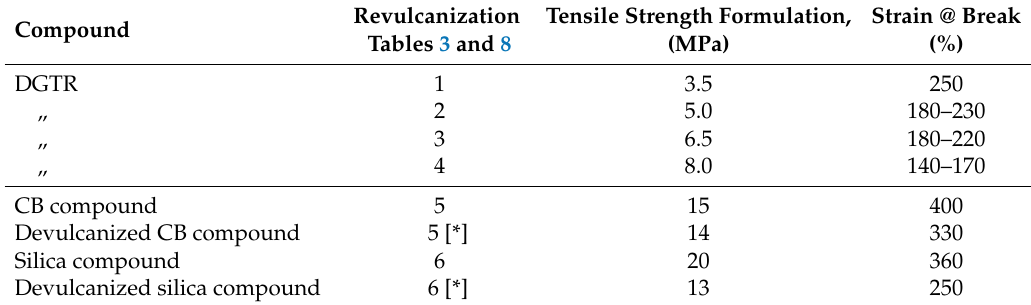
Table 11. Summary of tensile properties of (re)vulcanizates, [ * ] Components for revulcanization